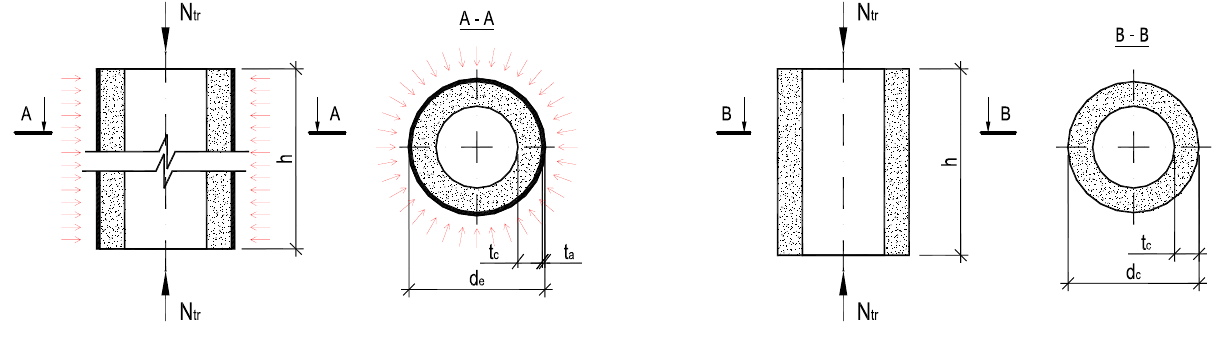
Fig 1 . HC-FST and HC specimens